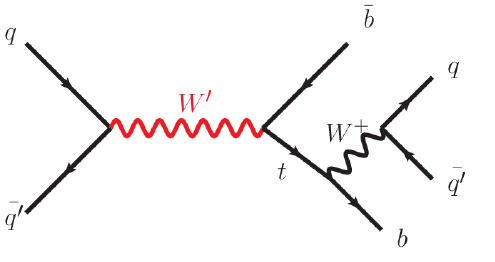
Figure 8. W (cid:48) boson production and its decay into top and bottom quarks [32]. The DeepJet algorithm is used for the b tagging of the jets related to bottom quark production and hadronisation. The jets are AK4 jets with p T > 500 GeV, and the thresholds for the taggers correspond to a misidentification rate of 5% for jets initiated by light quarks or gluons. However, the efficiency is reduced from 75% to 65% for jets with p T = 500 GeV and jets with p T = 1000 GeV, respectively, in the barrel region.